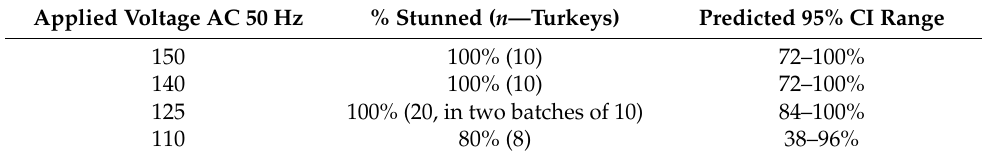
Table 1. Protocol for 10–20 turkeys per voltage treatment group, based on hypothetical results. Applied Voltage AC 50